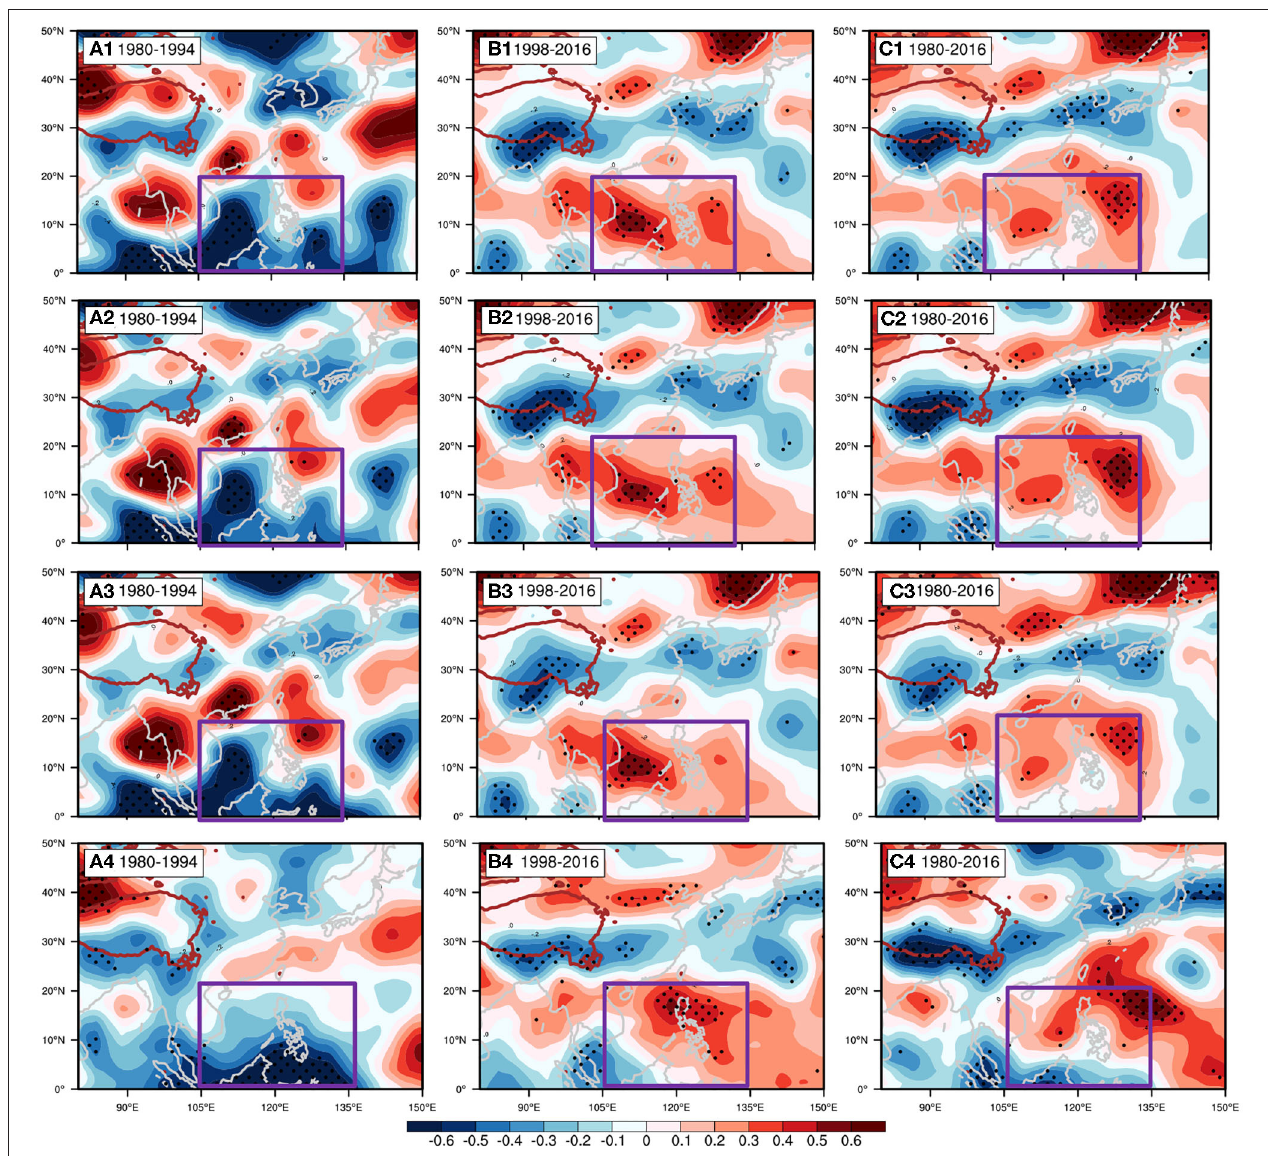
FIGURE 5 | Standardized partial regression coefficients between Tibetan Plateau temperature and summer precipitation (GPCP) during: (A) 1980–1994, (B) 1998–2016, and (C) 1980–2016. 1: station data, 2: JRA55, 3: ERA5, and 4: ERA–Interim data. The purple box areas represent the South China Sea. Black spots indicate significant differences above the 90% confidence level based on the Student’s t